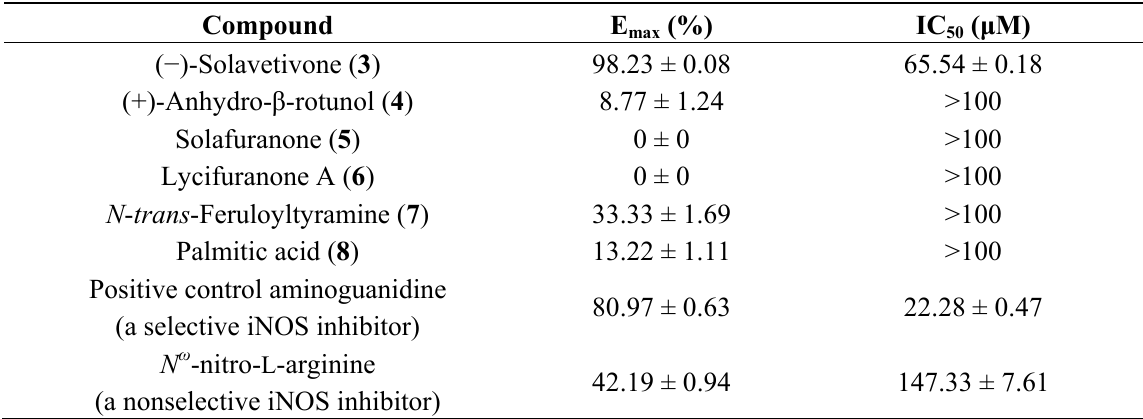
and IC of compounds 3 – 8 on nitrite production induced by LPS in Table 2. Mean E max 50 RAW 264.7